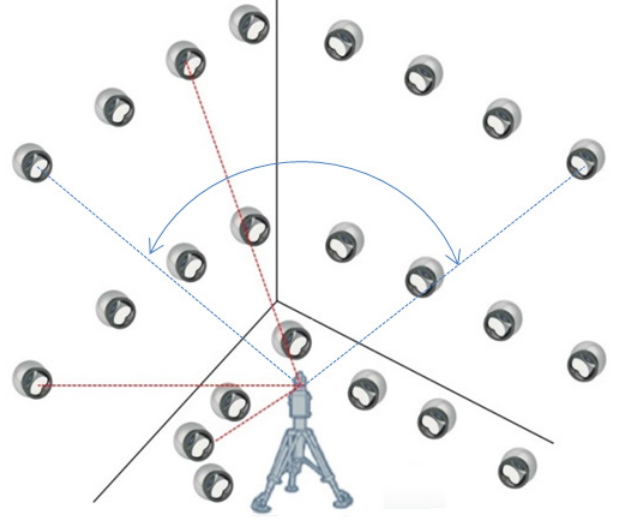
Figure 4. Reflector mesh positioning.